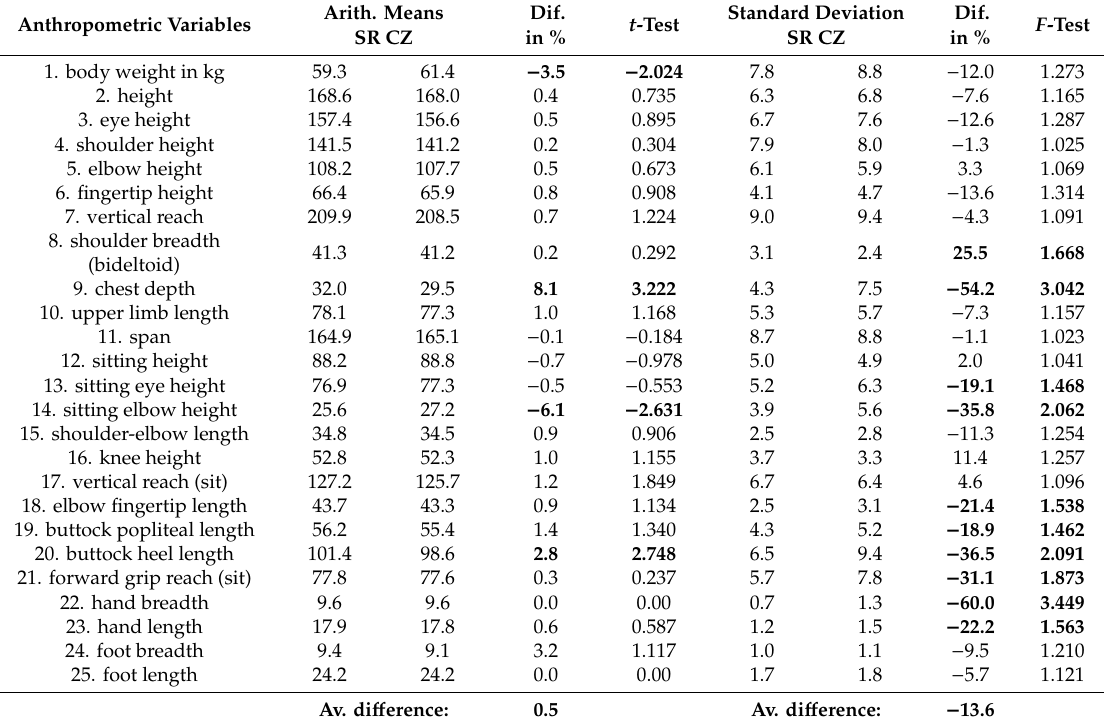
Table 1. Basic characteristics of anthropometric variables and their variation in the Slovak and Czech female population in the year 2004. Anthropometric Variables